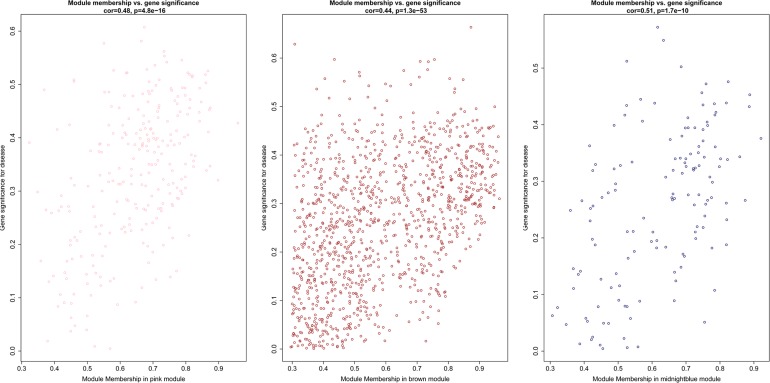
Scatter diagram for module membership vs. gene significance of stage (BD or non-BD) in three modules.